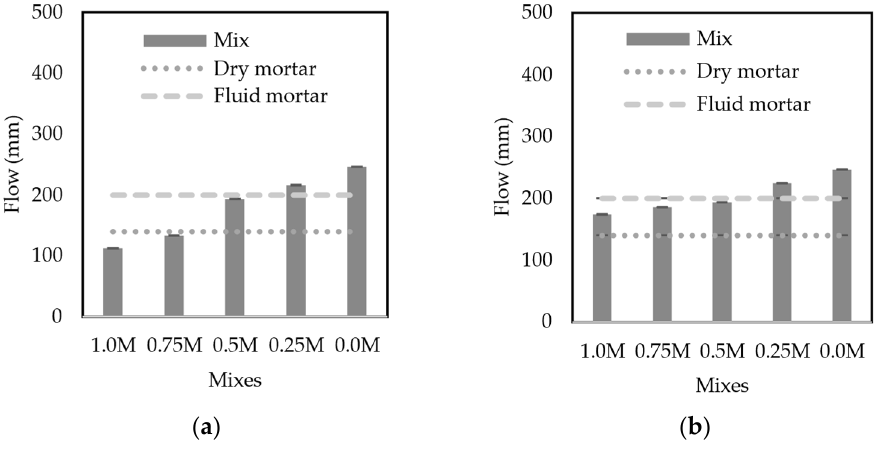
Figure 6. Flow values of: ( a ) OAA mixes and ( b ) CAA mixes.